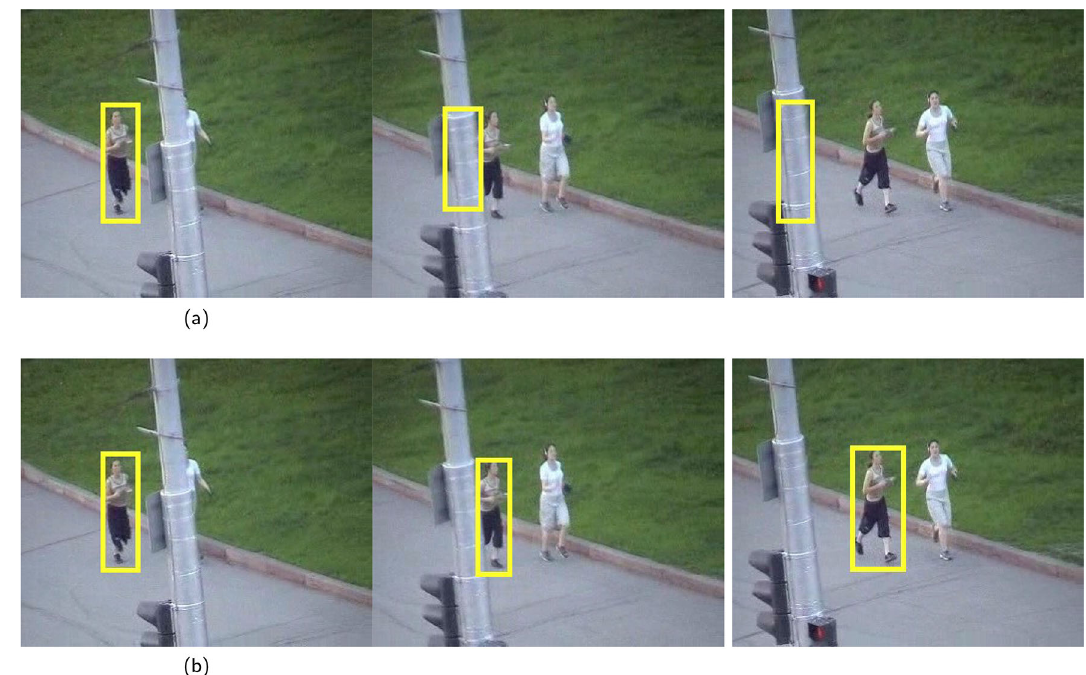
Fig. 5 a The result of Basic KCF algorithm tracking. b The result of KCF algorithm tracking with high confidence model update strategy added. The comparison of the two sets of pictures reveals that the KCF algorithm with a high-confidence model update strategy is better than